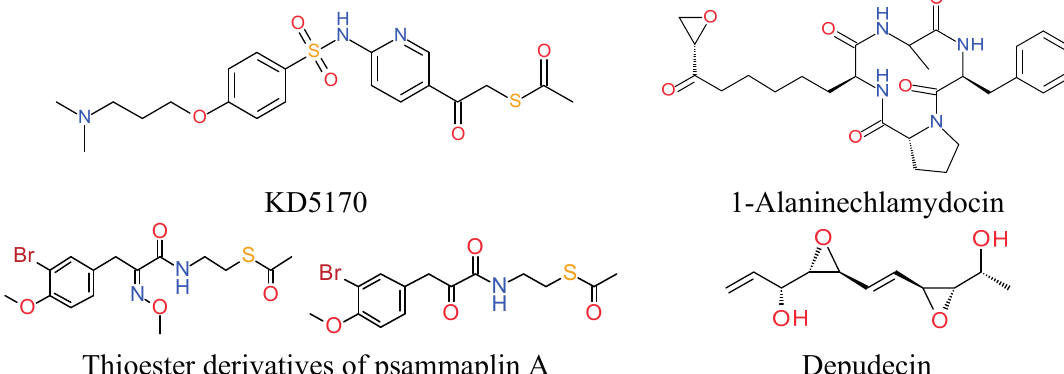
Figure 2. Structures of thioester- and epoxide-based HDAC